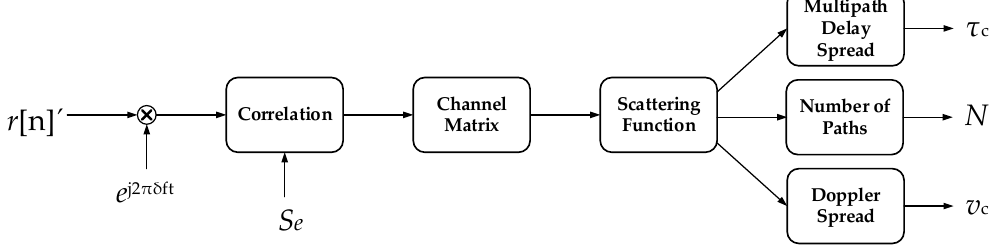
Figure 5. Diagram of the computation process for wideband channel